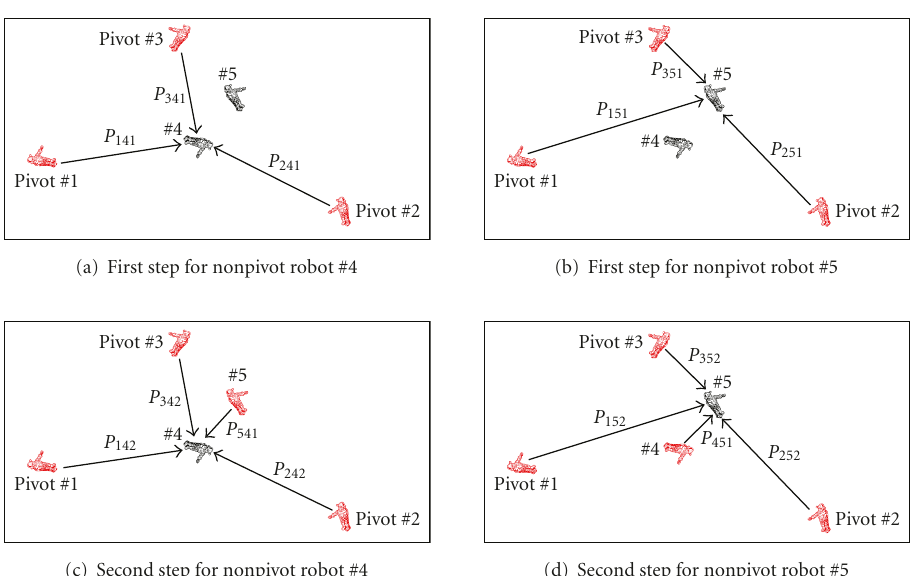
Figure 3: Iterative maximum likelihood location estimation with M = 5, N = 1, and Q =